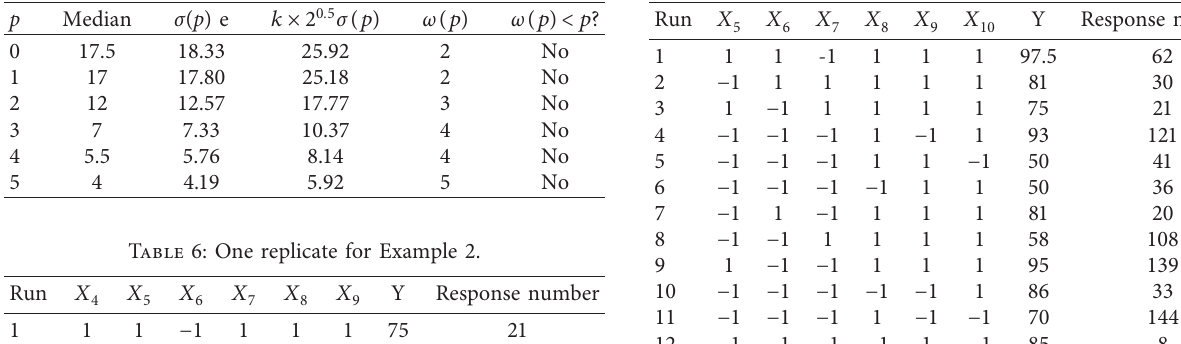
Table 5: step estimations for the investigation with the edge plan.